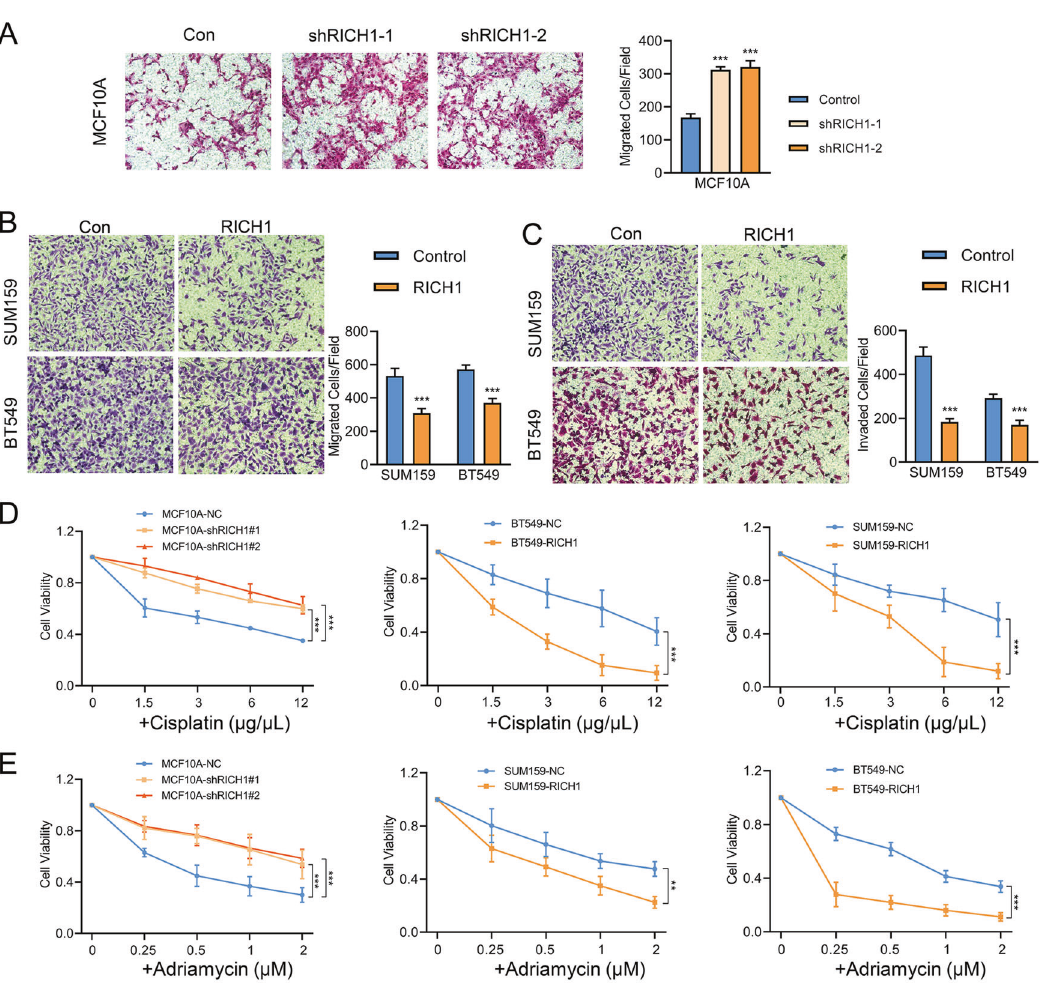
Fig. 4 RICH1 inhibits the invasion and metastasis of breast cancer and increases the sensitivity to chemotherapy drugs. A – C . Cell migration and invasion assessed by transwell assay. The number of migrated or invaded cells were presented as the mean ± SD of three independent experiments. D CCK8 assays of NC- and RICH1-intervention cells after cisplatin ( D ) and adriamycin ( E ) treatment in various concentrations. All the experiments were repeated three times independently with similar results. Data represent mean ± SD. Statistical signi fi cance was determined by two-tailed unpaired t -test. Abbreviation: ** p < 0.01; *** p <